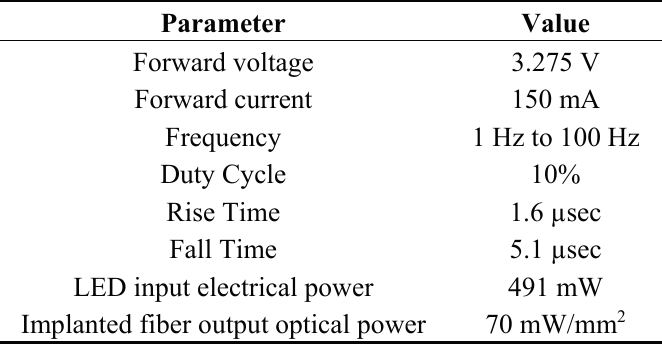
Table 2. Optical stimulator characteristics.